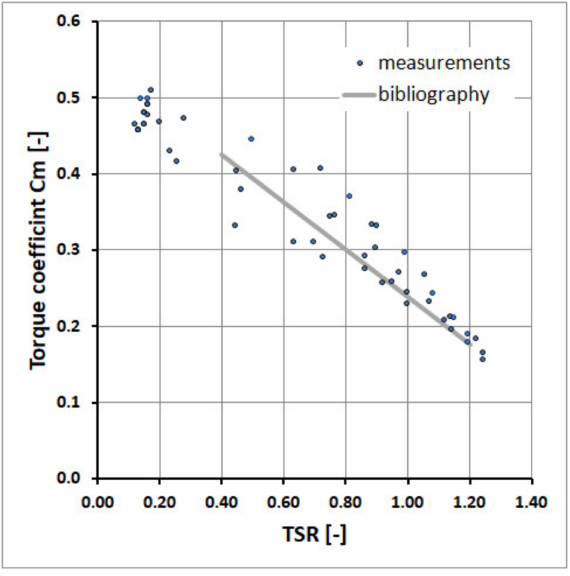
Figure 8. Torque coefficient for single-segment rotor and data from [16].